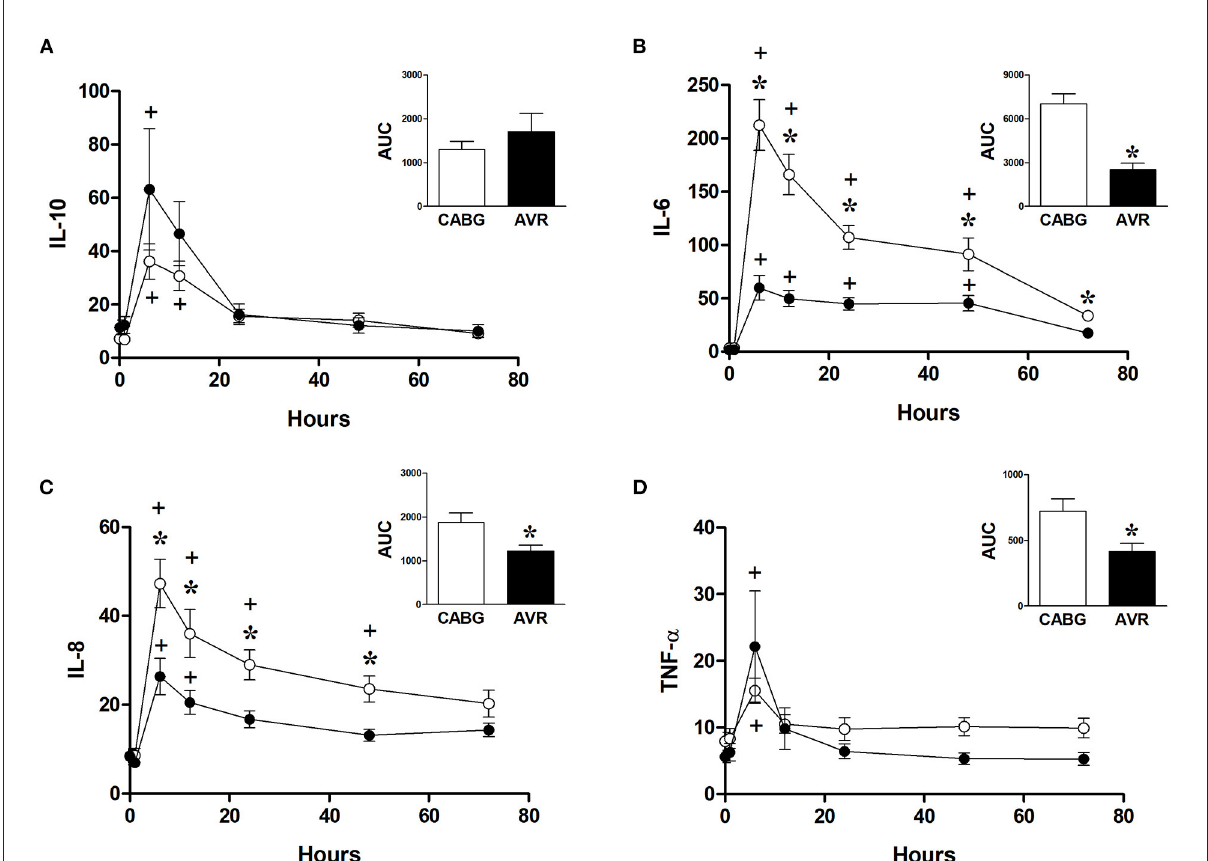
FIGURE5 Postoperative changes in inflammatory markers in CABG and AVR patients. Values (pg/ml) are mean ± SEM for levels of IL-10 (A) , IL-6 (B) , IL-8 (C) , and TNF- α (D) , in patients undergoing CABG (white) or AVR (black) surgery. Analysis by two-way mixed model ANOVA did not reveal any significant differences for (A) or (D) , whilst in (B) , and (C) a significant interaction was found between time and operation type; * represents a significant effect of operation type (CABG vs. AVR) at individual timepoints. One-way ANOVAs with post-hoc Dunnett’s test where appropriate were also performed individually for each surgery type; + represents a significant difference compared to basal levels. AUC (area under the curve) was analyzed using unpaired two-tailed student’s t -test or Mann-Whitney U -test as appropriate; * Represents a significant difference between